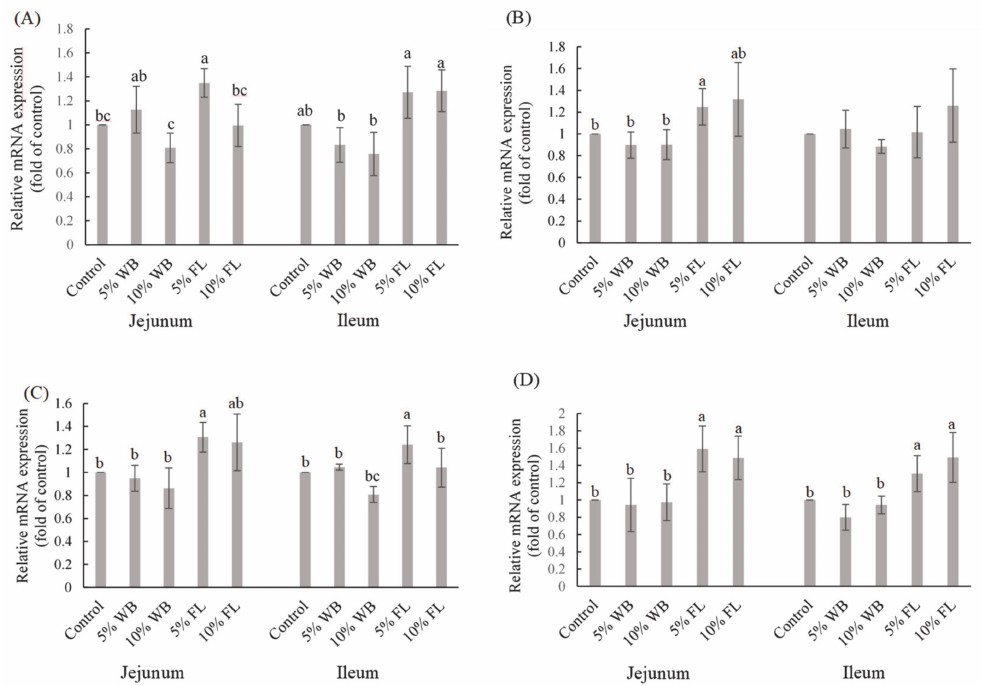
Figure 2. The effects of FL supplementation on ZO-1 ( A ), CLDN-1 ( B ), MUC-2 ( C ), and OCLN ( D ) mRNA expression in the jejunum and ileum of 35-d-old broiler chickens. Values are expressed as the mean ± standard deviation ( n = 6). a–c Means within the same rows, without the same superscript letter, are significantly different ( p < 0.05). WB: Wheat Bran; FL: Laetiporus sulphureus fermented product; ZO-1 : Zonula occludens-1; CLDN-1 : Claudin-1: MUC-2 : Mucin - 2; OCLN :